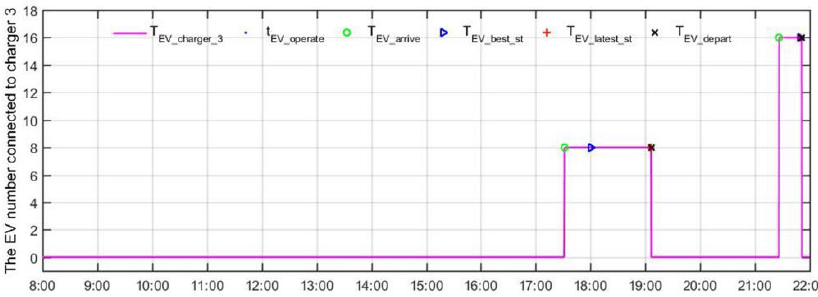
Figure 30. Operating time of EVs connected to charger 3 under SPVA.